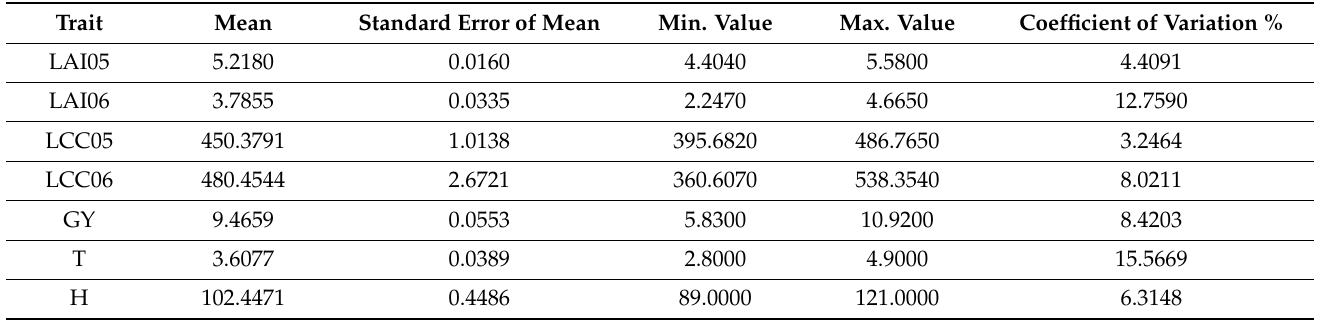
Table 12. Descriptive statistics of the studied phenotypic traits. LAI05, LAI06, LCC05, and LCC06 are modelled traits with GPR. GY, T, and H are ground-measured